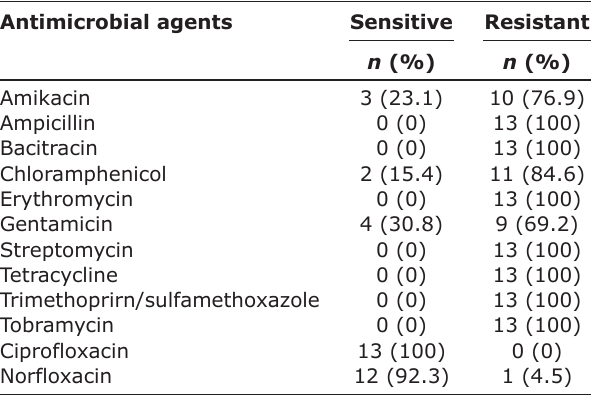
Table-4: Antibiotic sensitivity test of (13) Pseudomonas aeruginosa strains isolated from sheep and goat. Antimicrobial